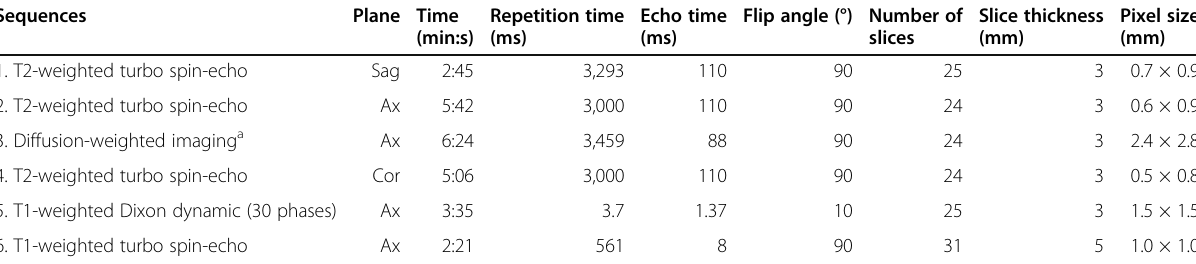
Table 2 3-T multiparametric magnetic resonance imaging protocol for patient selection